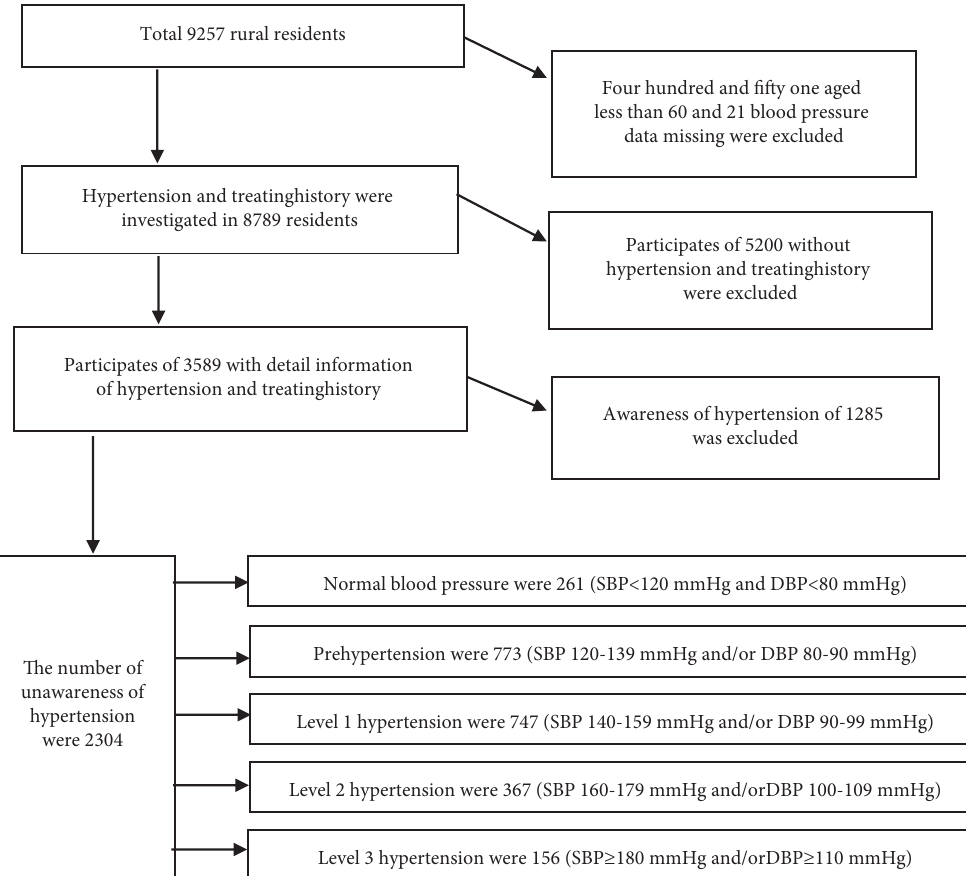
Figure 1: Data process flow for investigating the prevalence of hypertension without awareness of disease history in a rural area in Shandong province,